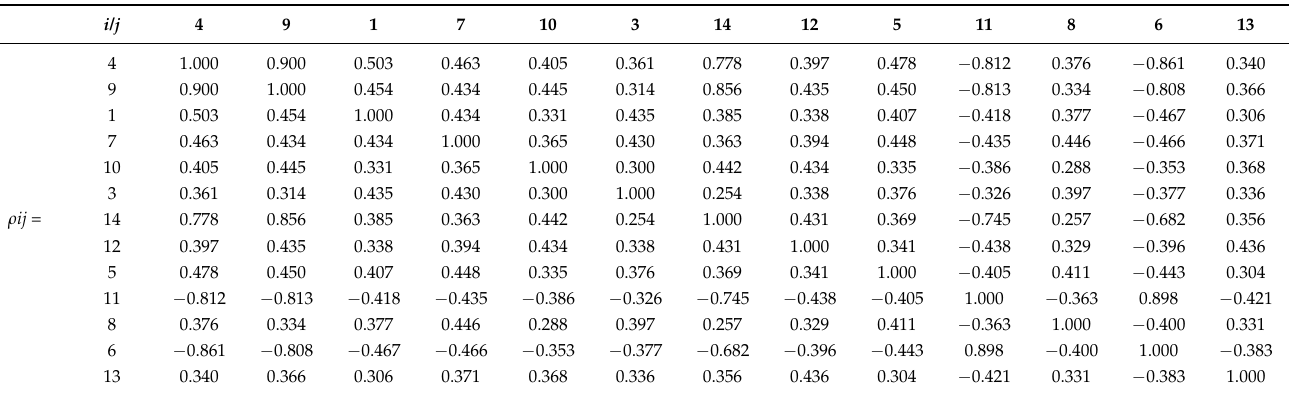
Table 4. The correlation coefficient matrix for the damaged